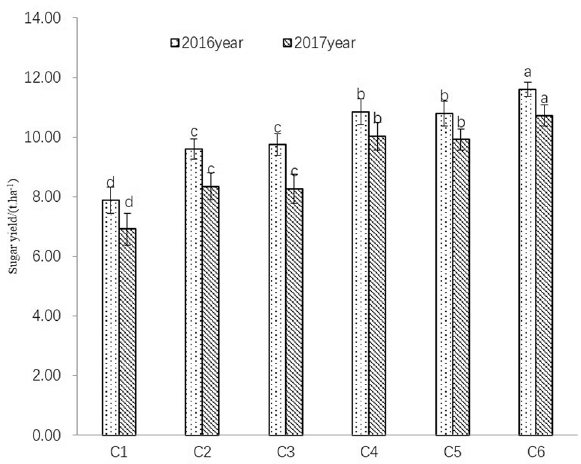
Figure 8. Effect of limited irrigation on the sugar yield of sugar beet in acquisition stage. Different lowercase letters in the same column indicate significant differences ( p < 0.05) among different treatments in the same